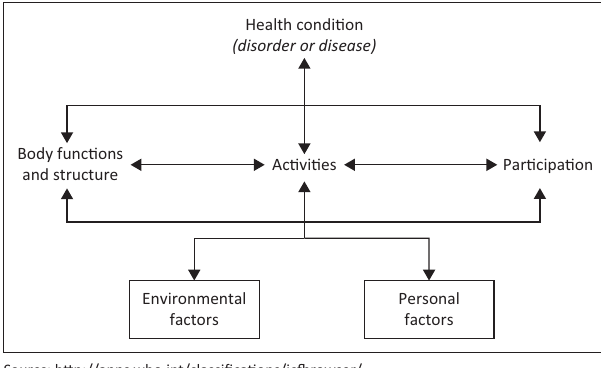
FIGURE 1: The International Classification of Functioning, Disability and Health model (World Health Organisation).